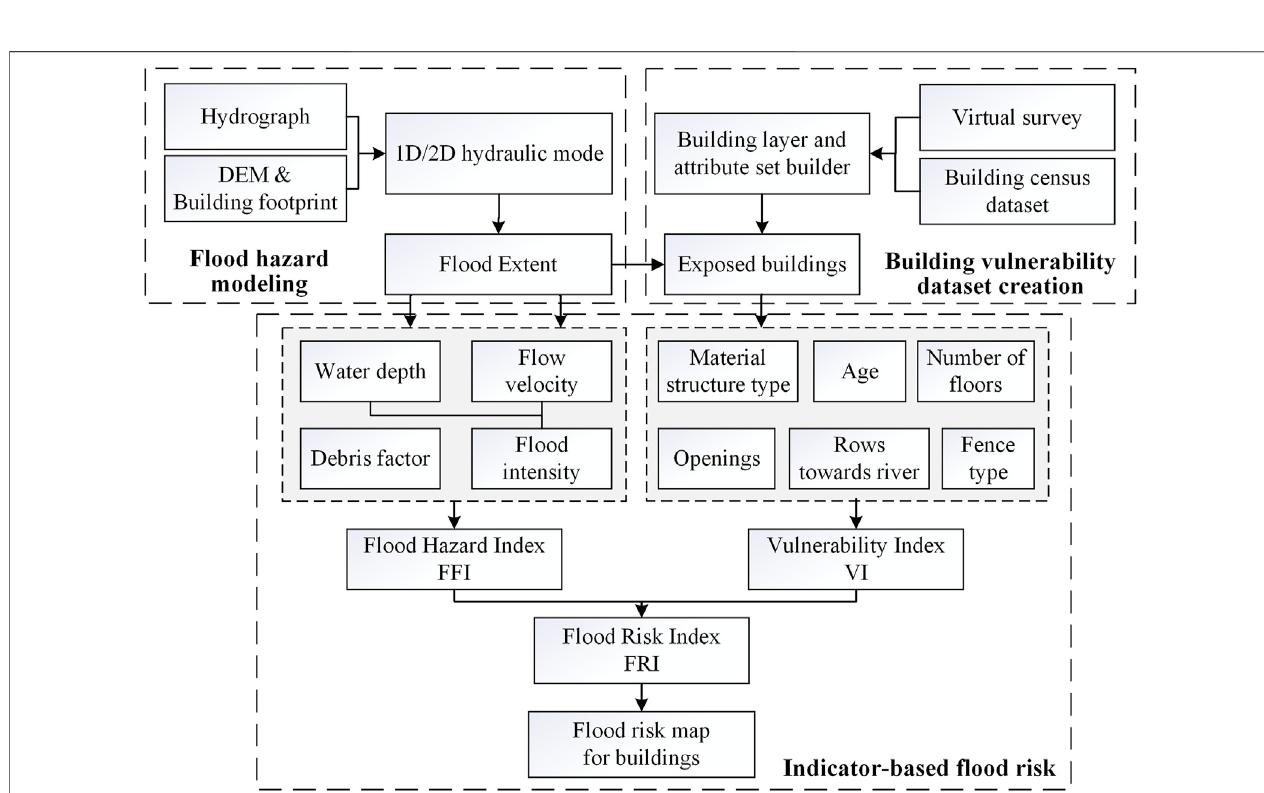
FIGURE 2 | Flowchart of fl ood risk assessment of buildings.